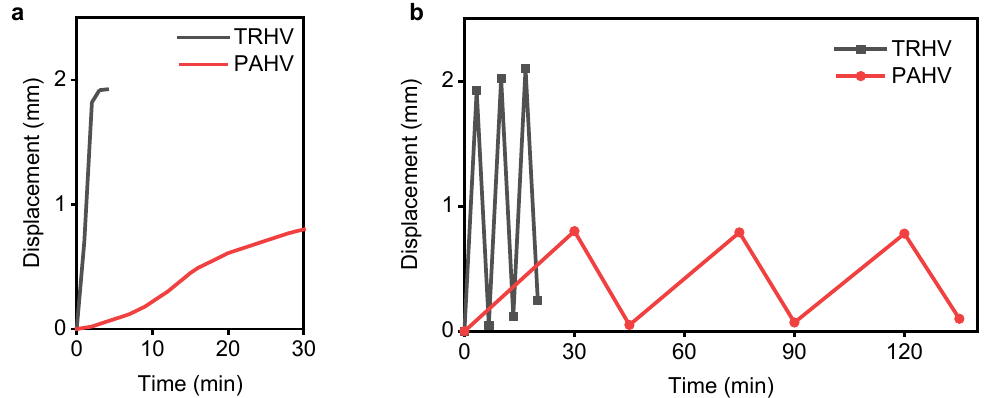
Figure 9. NPHV and PAHV thermo-mechanical performance comparison. ( a ) The NPHV’s and PAHV’s displacement during actuation at 40 ◦ C. ( b ) The NPHV’s and PAHV’s displacement for three actuation